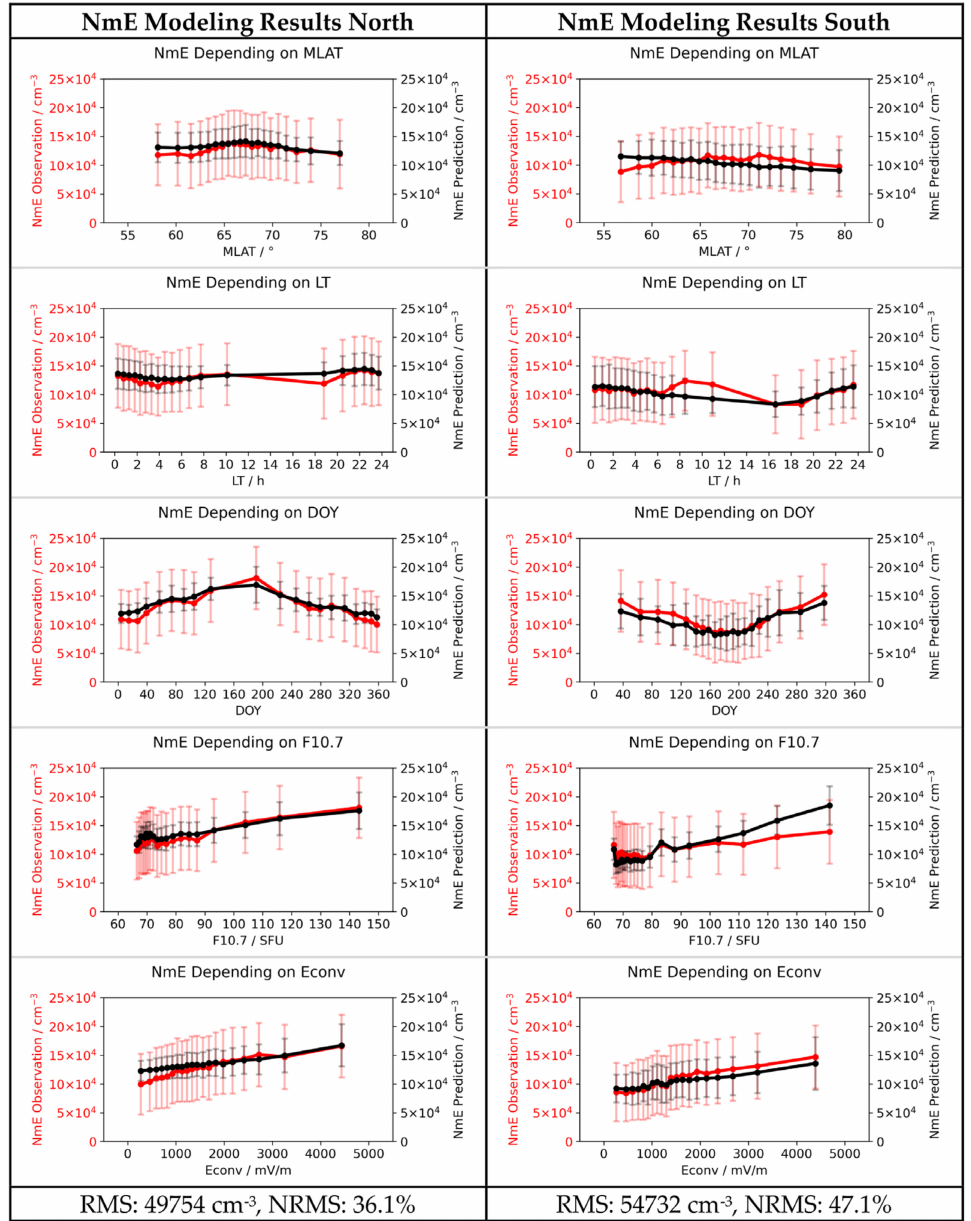
Figure 2. Observed (red) and predicted (black) NmE trends for the modeling dataset. Left column: Northern Hemisphere. Right column: Southern Hemisphere. Last row: root mean square deviation (RMS) and normalized RMS (NRMS) between observation and